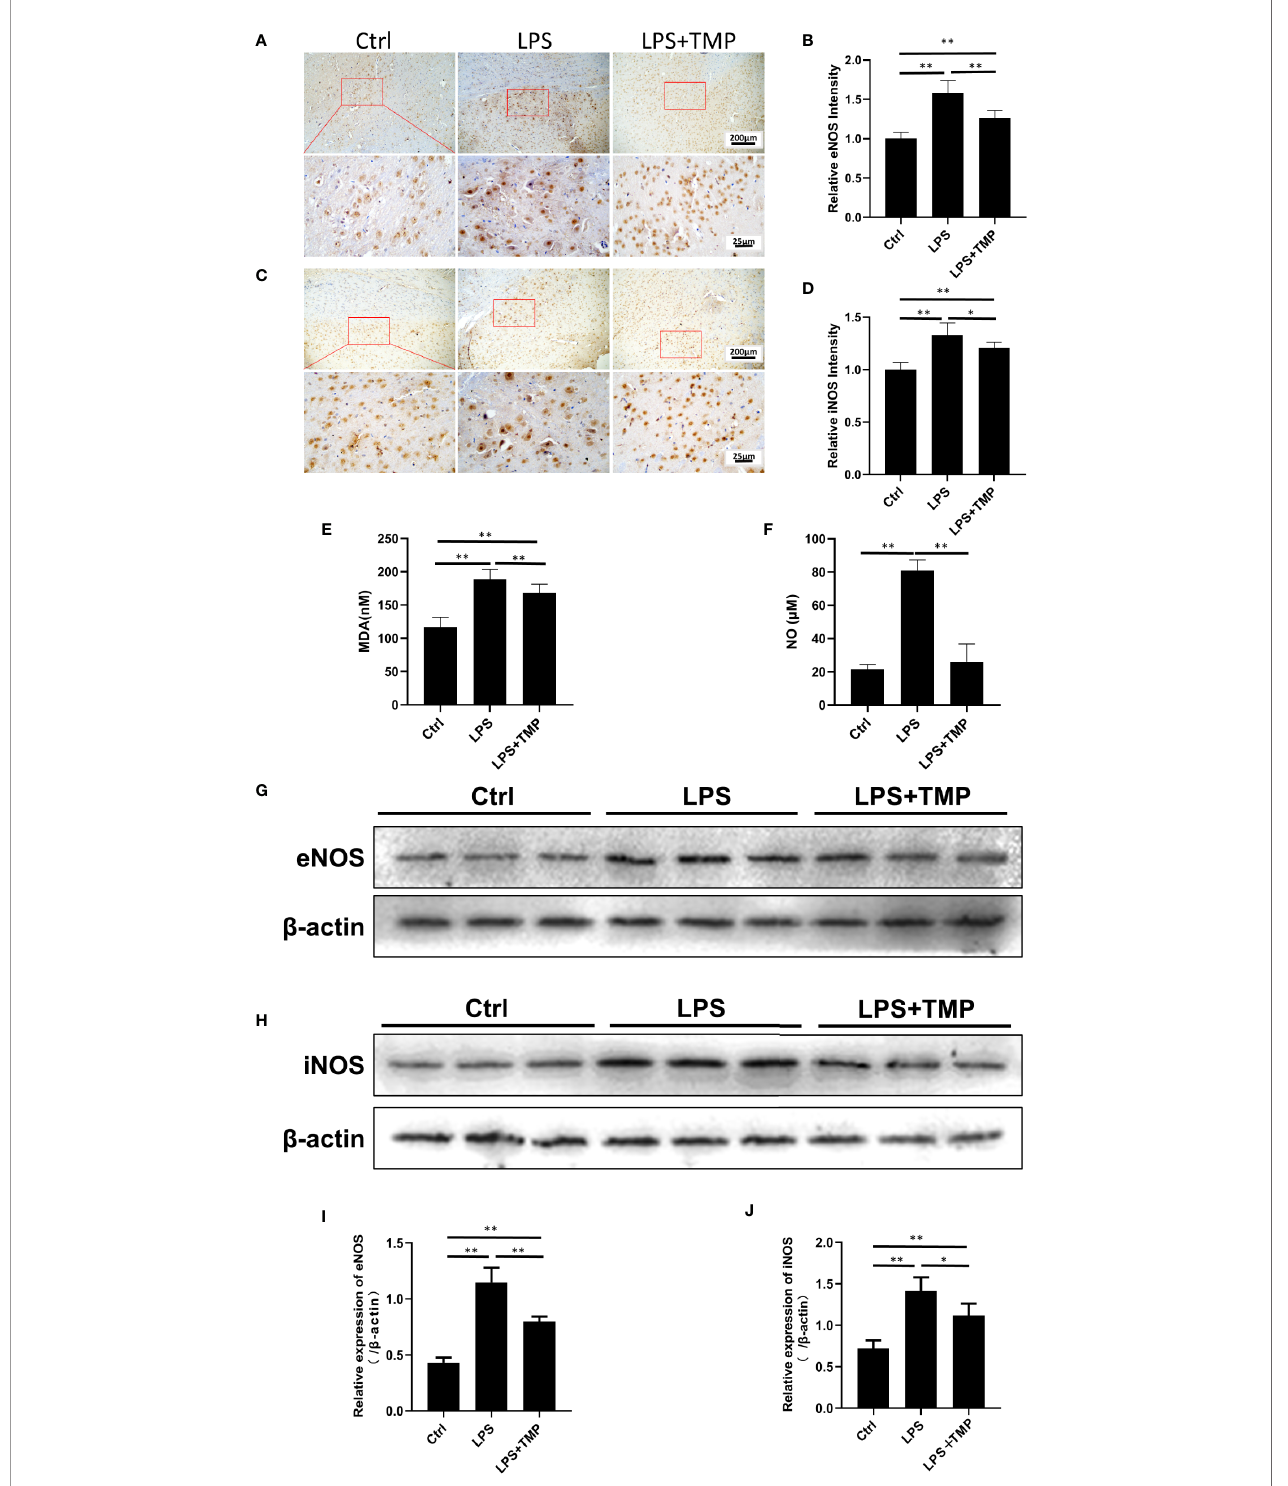
FIGURE 5 | Effects of TMP on NOS and serum MDA and NO. (A) IHC staining of the eNOS in cerebral cortex of the rats (Upper, 100×; Lower, 400×). (B) The relative IHC intensity of eNOS protein; (C) IHC staining of the iNOS in cerebral cortex of the rats (Upper, 100×; Lower, 400×). (D) The relative IHC intensity of iNOS protein; (E, F) Serum MDA and NO contents in the control group, LPS group and LPS+TMP group ( n =8). (G – J) Western blot was used to detect the expression levels of eNOS and iNOS in rat cerebral cortex and histogram shown the quanti fi ed results. Compared with the LPS group, * P < 0.05, ** P <